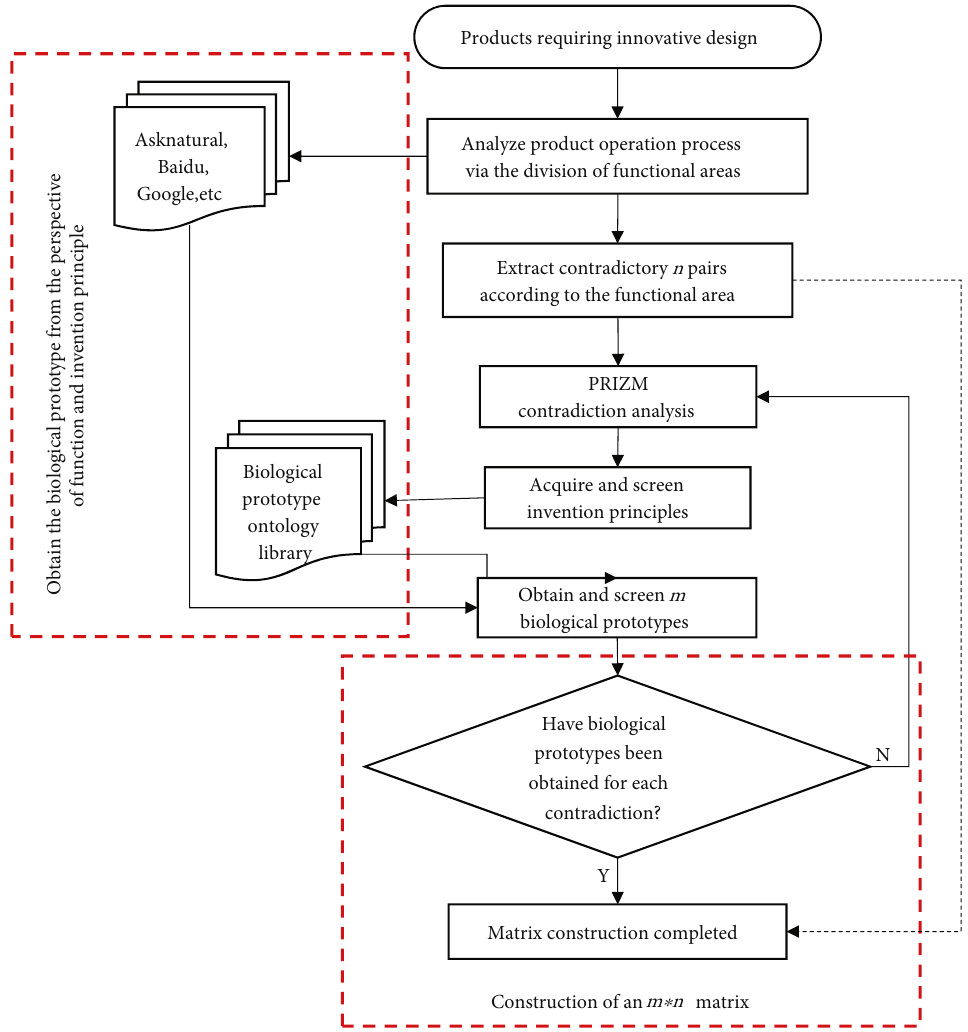
Figure 1: The fl owchart of the construction of the biological prototype matrix based on